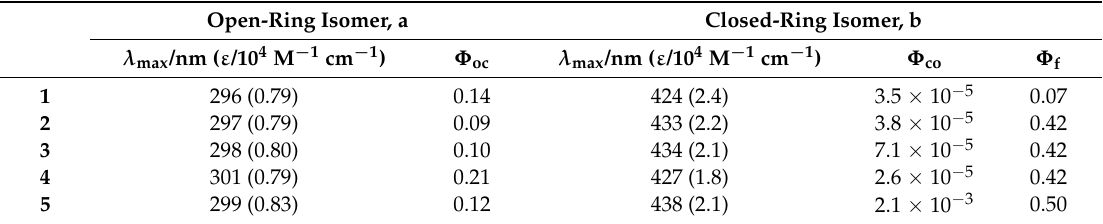
Table 1. Photophysical and photochemical properties of 1 – 5 in 1,4-dioxane. Open-Ring Isomer, a Closed-Ring Isomer, b